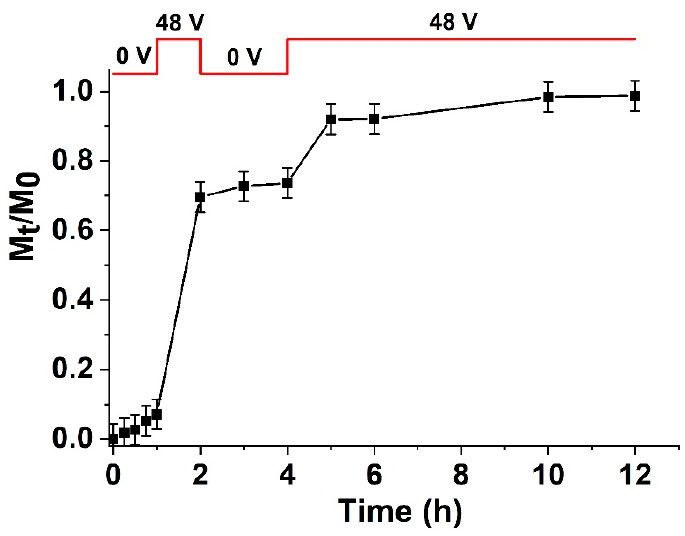
Figure 7. CUR release from 𝐻 (cid:3002)(cid:2879)(cid:3008)(cid:3016)(cid:3004) under changeable voltage: 0 V (1 h), 48 V (1 h), 0 V (2 h), and 48 V (8 h).